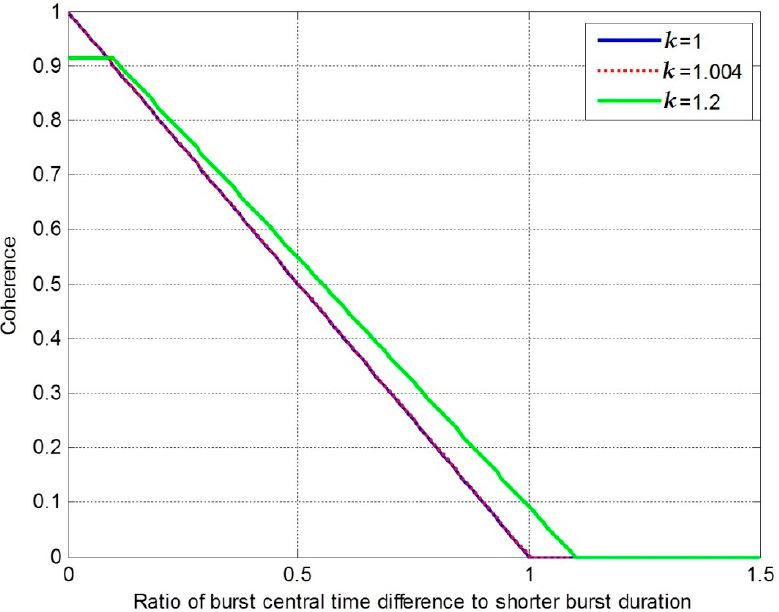
Figure 3. The relationship between the ratio of burst central time di ff erence to shorter burst duration and coherence.